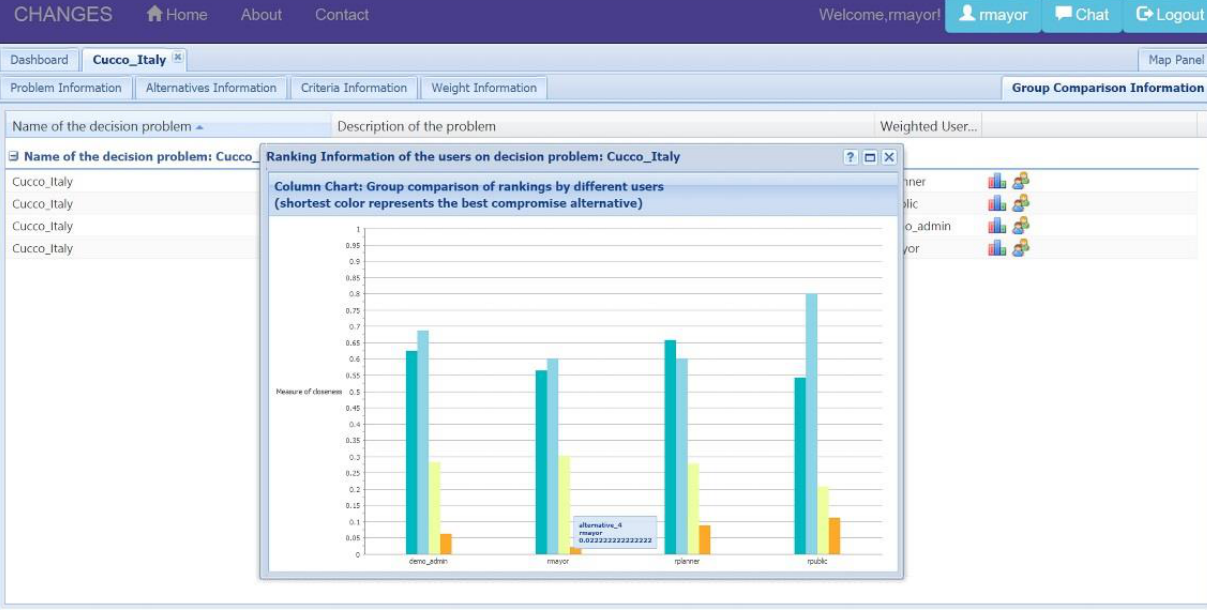
Figure 16. Group comparison of the ranking results by the